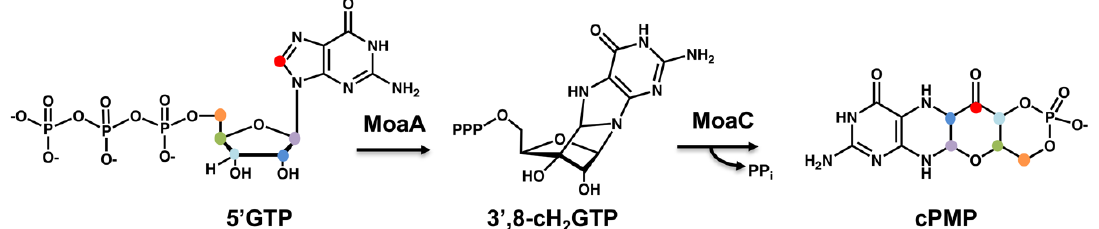
Figure 7. The conversion of 5 ′ GTP to cPMP involving the functions of MoaA and MoaC. The colors on 5 ′ GTP and cPMP indicate the source of the carbon and nitrogen atoms in cPMP as determined by isotope labeling studies. The reaction involves the formation of 3 ′ ,8-cH2GTP as the product of MoaA and the substrate for MoaC.